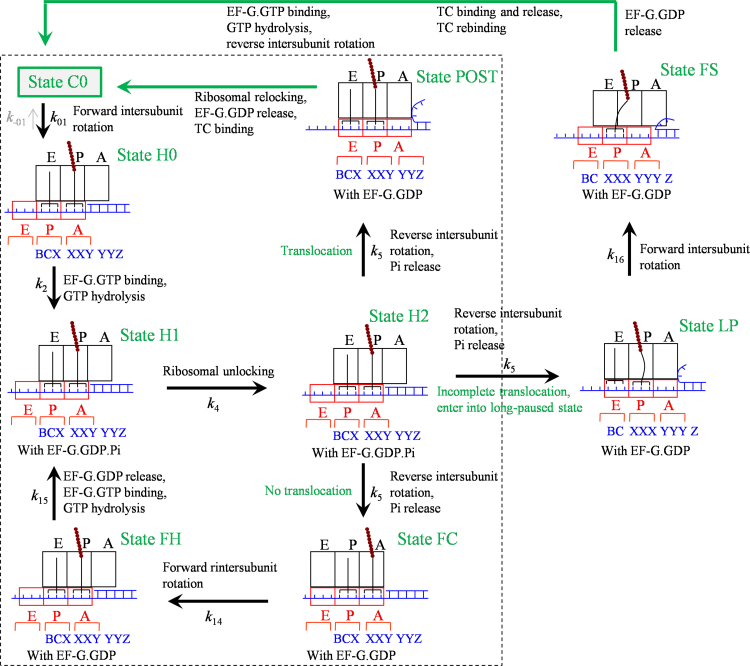
Schematic representation of the elongation pathway for ribosome translation through the mRNA duplex at the slippery site (see text for detailed description). The transitions from State FS to State C0 are shown in Fig. 4. The transitions from State NF to State C0 are similar to the transitions from State FS to State C0. Note that the transitions inside the box correspond to the transitions in Fig. 2.